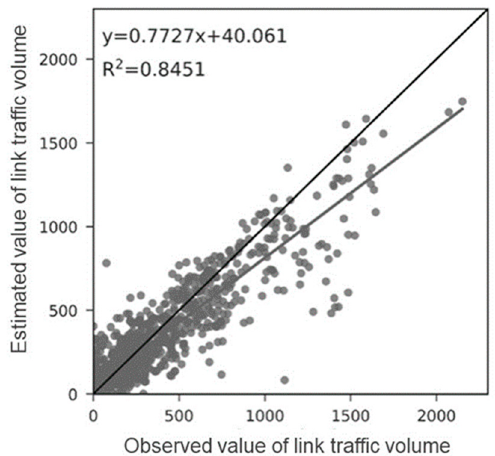
Figure 7. The scatter plots representing estimated volume of link traffic using the optimal solution. Diagonal line indicates y = x.